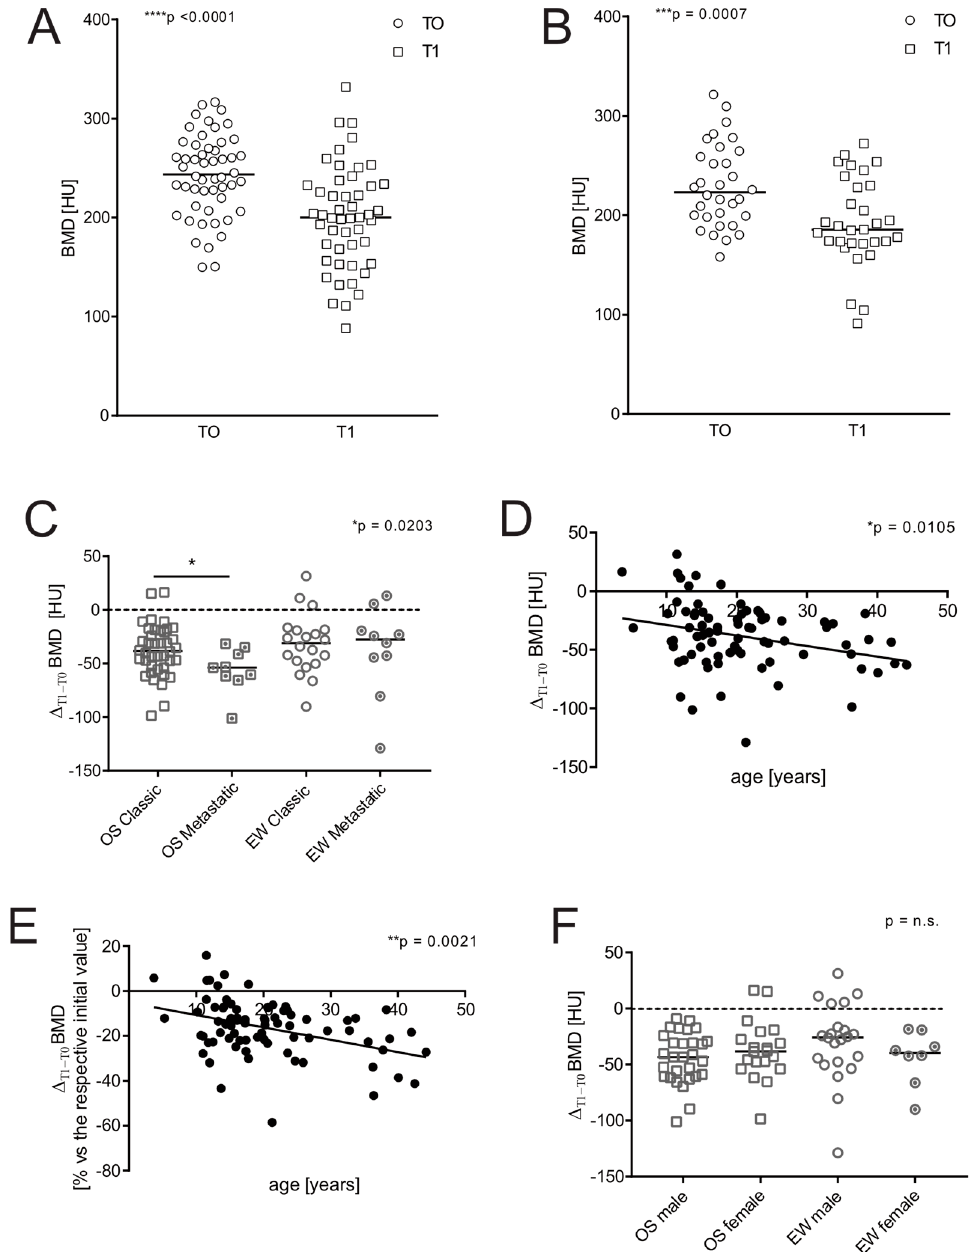
Figure 2. Effect of age, sex, and clinical features on BMD at 1 year after treatments of patients with bone sarcoma. In OS ( n = 52), EW ( n = 31) patients, immediately after completion of treatment protocols (around 1 year after diagnosis, T1), BMD was re-measured with the same method used at T0, by CT assessment. ( A ) Values and median of BMD at T0 vs. T1 of OS patients (Mann–Whitney U test, **** p < 0.0001); ( B ) values and median of BMD at T0 vs. T1 of OS patients (Mann–Whitney U test, *** p < 0.001); ( C ) values of Δ T1–T0 BMD (difference between BMD value at T1 respect to BMD value at T0) shown in panel B, divided by the presence/absence of clinically relevant metastases at diagnosis (Mann–Whitney U test, * p < 0.05); ( D ) correlation between Δ T1–T0 BMD values shown in panel B and age (OS and EW patients were grouped together, Spearman correlation test, * p < 0.05); ( E ) correlation between the percentage of BMD loss at T1, compared with the BMD value at T0 of the same patient and age (OS and EW patients were grouped together, Spearman correlation test, ** p < 0.005); ( F ); Δ T1–T0 BMD values and median shown in panel B, divided by gender (Mann–Whitney U test).